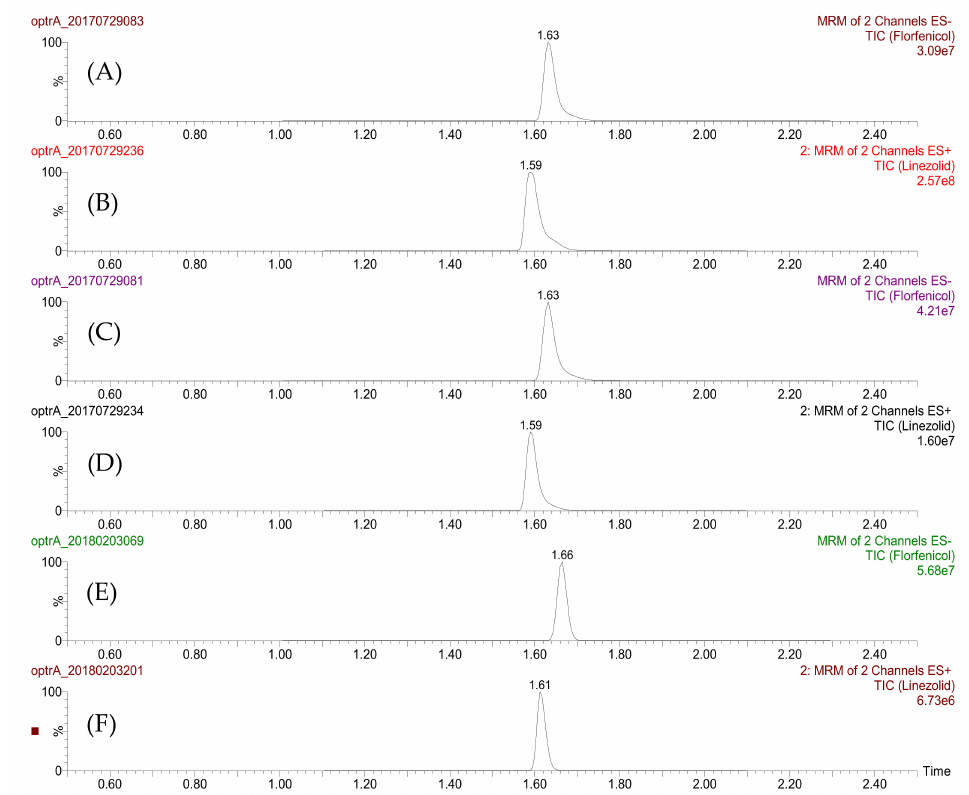
Figure 2. Representative UHPLC-MS/MS chromatograms of florfenicol and linezolid in tested isolates. ( A ) Standard of florfenicol at concentration of 50 µ g/L. ( B ) Standard of linezolid at concentration of 50 µ g/L. ( C ) Florfenicol at concentration of 64 mg/L in E. faecalis JH2-2/pAM401+ optrA at 60 min. ( D ) Linezolid at concentration of 8 mg/L in E. faecalis JH2-2/pAM401+ optrA at 60 min. ( E ) Florfenicol at concentration of 64 mg/L in S. aureus RN4220/pAM401+ optrA at 60 min. ( F ) Linezolid at concentration of 8 mg/L in S. aureus RN4220/pAM401+ optrA at 60